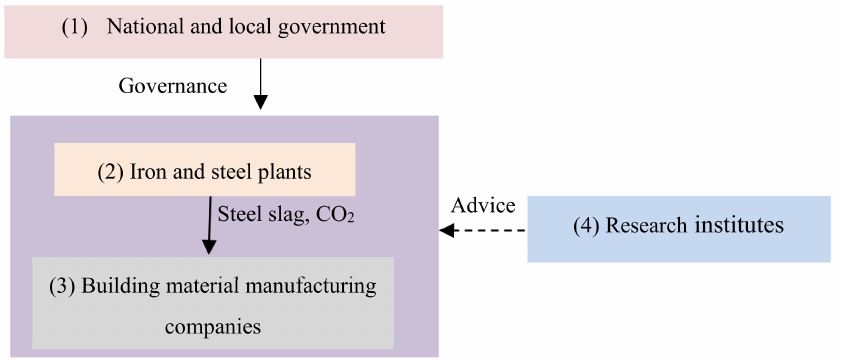
Figure 6. The chain of stakeholder categories of carbonation curing on steel